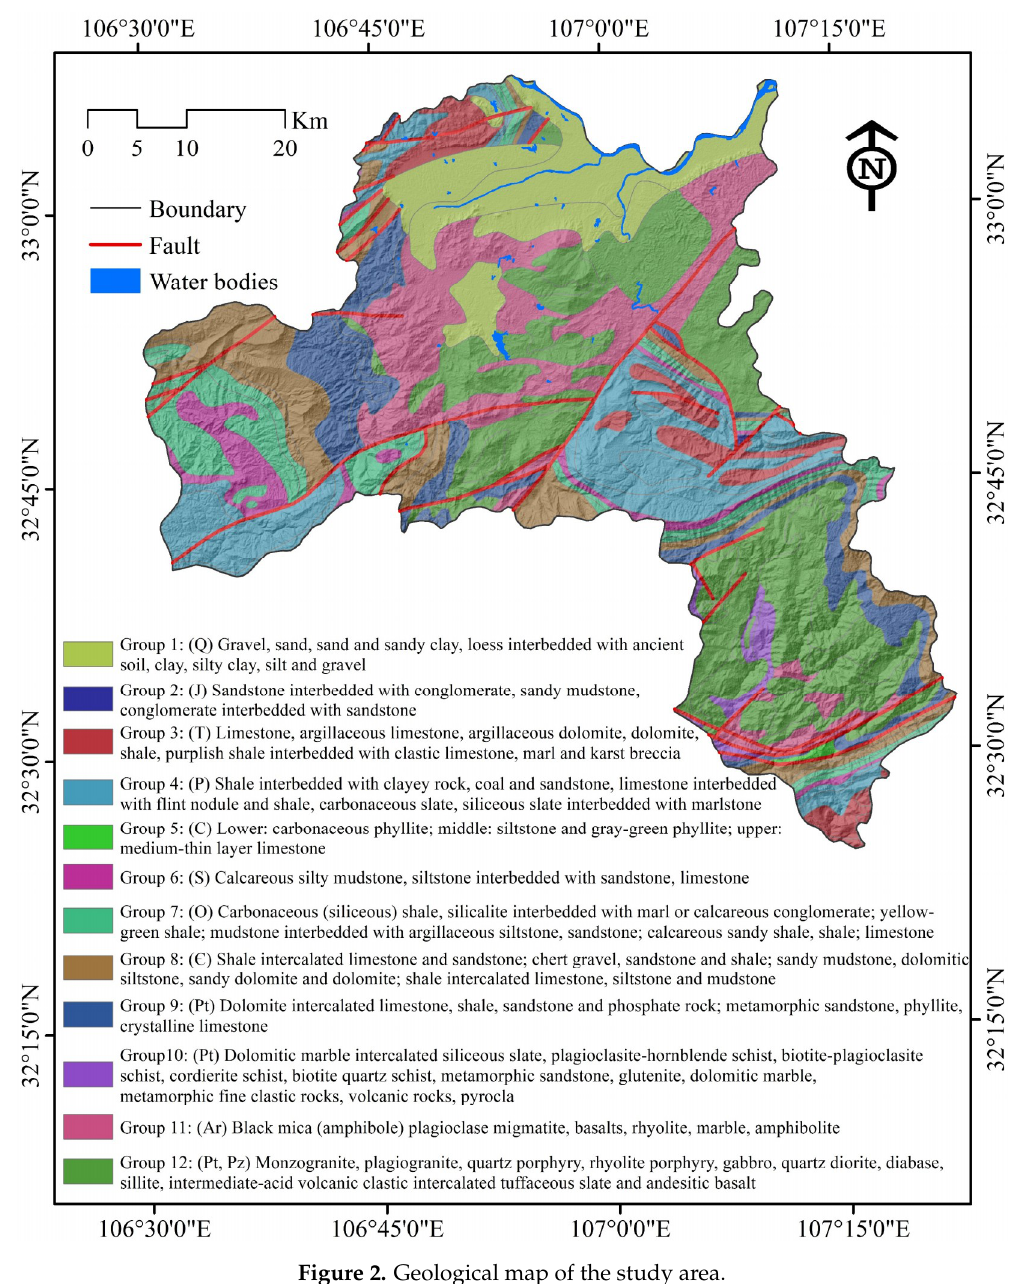
Figure 2. Geological map of the study area.